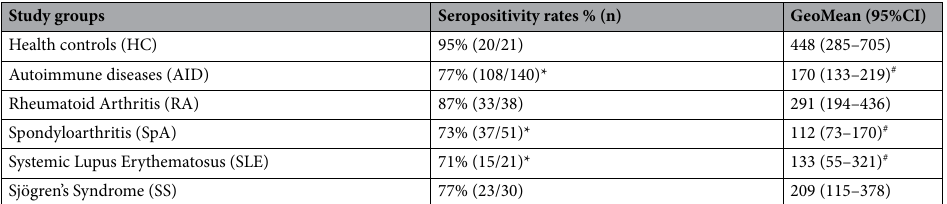
Table 1. Seropositivity Rates and Neutralizing Antibodies Levels in Patients with Autoimmune Disease upon Planed Primary 17DD-YF Vaccination. Data are reported as the proportion of seropositivity upon planed primary 17DD-YF vaccination and geometric mean (GeoMean) of plaque-reduction neutralizing test (PRNT). * Significant difference at p < 0.05 by χ 2 test. # Significant difference at p < 0.05 by Kruskal–Wallis analysis followed by Dunn’s post test.